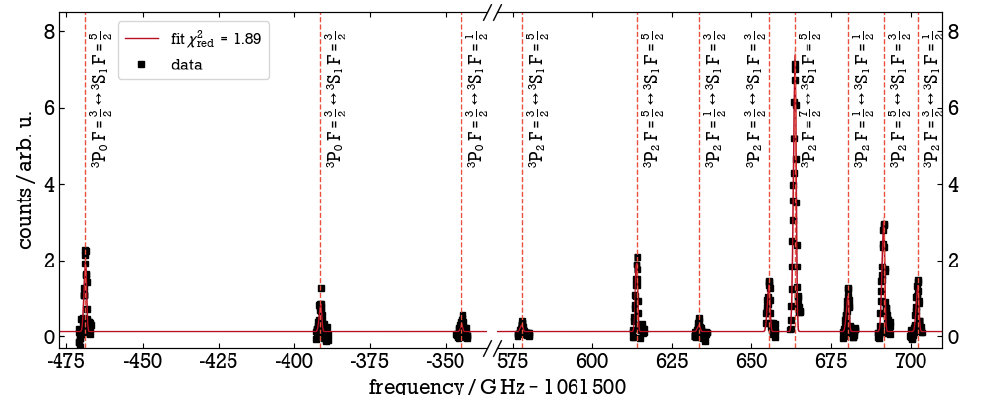
Figure 5. Complete hyperfine spectrum of the 2 3 S 1 → 2 3 P 0 and 2 3 S 1 → 2 3 P 2 fine-structure transitions including the fit of the hyperfine transitions, including hyperfine-induced fine-structure mixing, as discussed in the text. The individual transitions are indicated at the resonances.